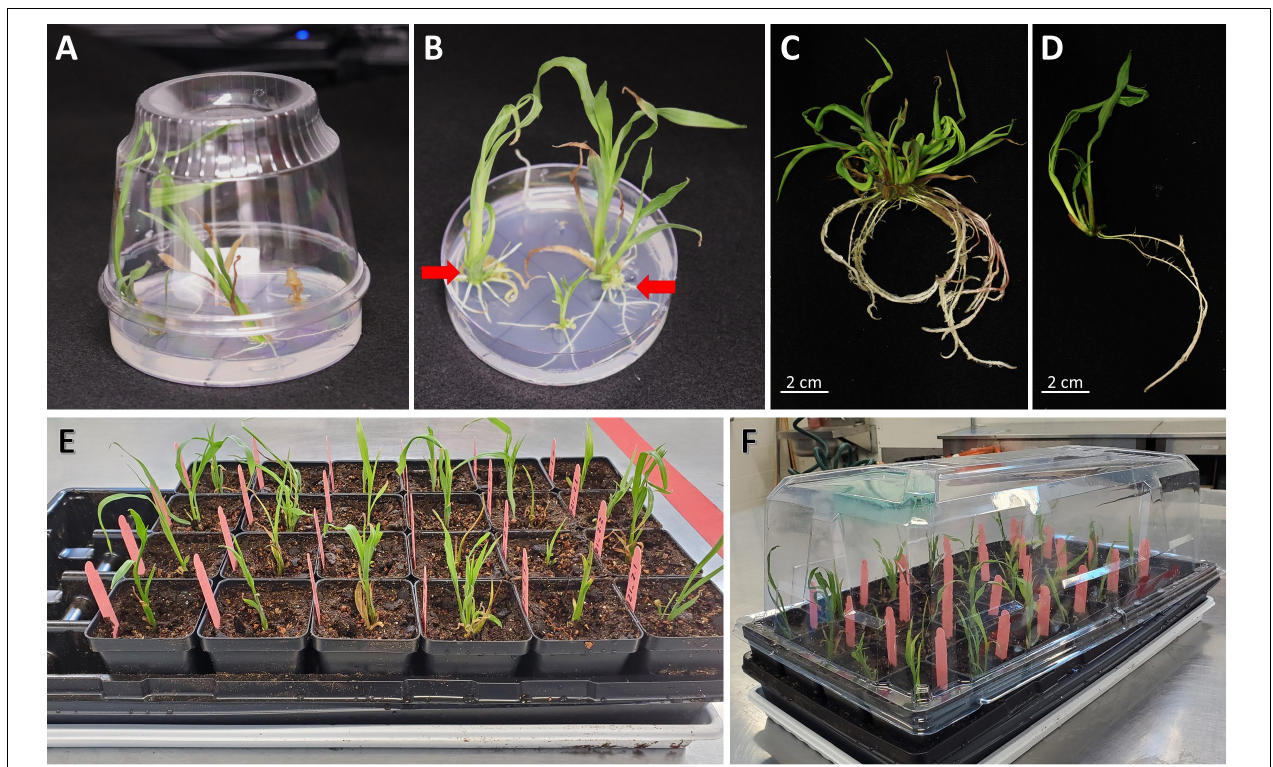
FIGURE 4 | Regenerated T0 plantlets from rooting stage to acclimatization in soil. (A) Plantlets growing on the rooting medium. Sundae cup is used as a cover to give vertical space to grow. (B) Regenerated plantlets ready to be moved to potting mix. Red arrows indicate plantlets with healthy roots. (C) Plantlet representing bushy phenotype or multiple shoot cluster. (D) Single-shoot plantlet ready to be transplanted to potting mix. (E) T0 regenerated plantlets transplanted to potting mix. (F) A plant propagation tray covered with a humi-dome to aid in